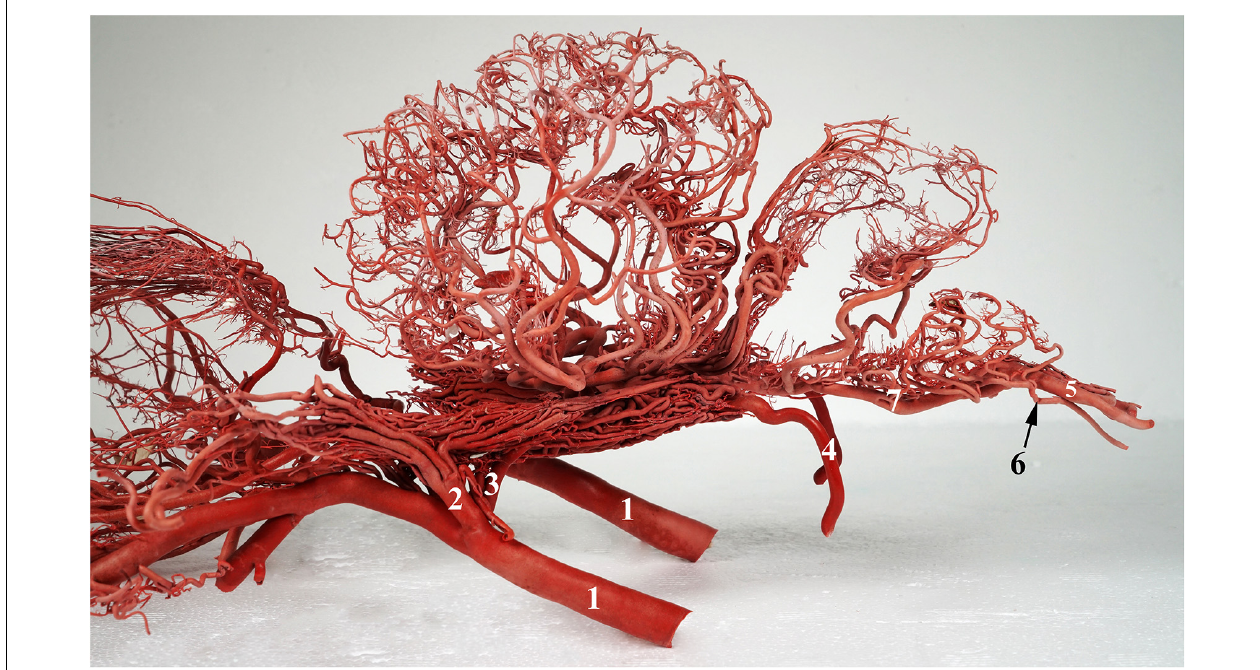
FIGURE 1 | A photograph showing the arterial supply to the dromedary brain (left lateral view). 1, maxillary artery; 2, external ophthalmic artery; 3, rostral branches to the rostral epidural rete mirabile (RERM); 4, internal carotid artery; 5, vertebral artery; 6, lateral branch of the vertebral artery; and 7, basilar artery. Note: middle meningeal artery was not a dominant supplier to RERM in this